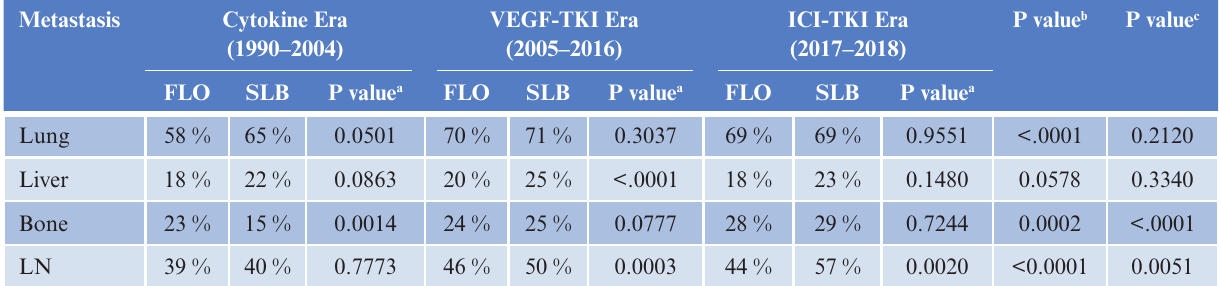
Table 2: Percentage of metastasis by treatment era for all included studies (N=127).